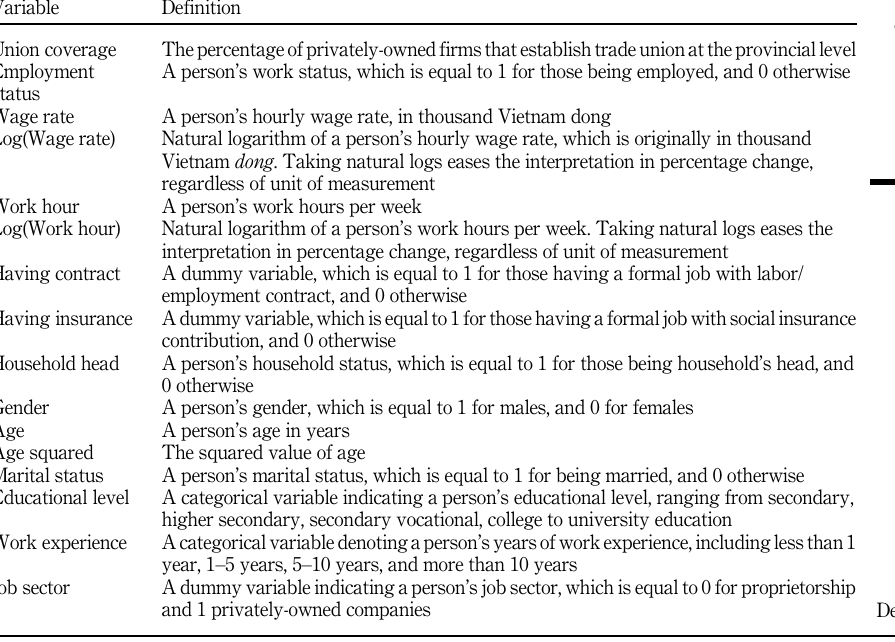
Table 1. Definition of